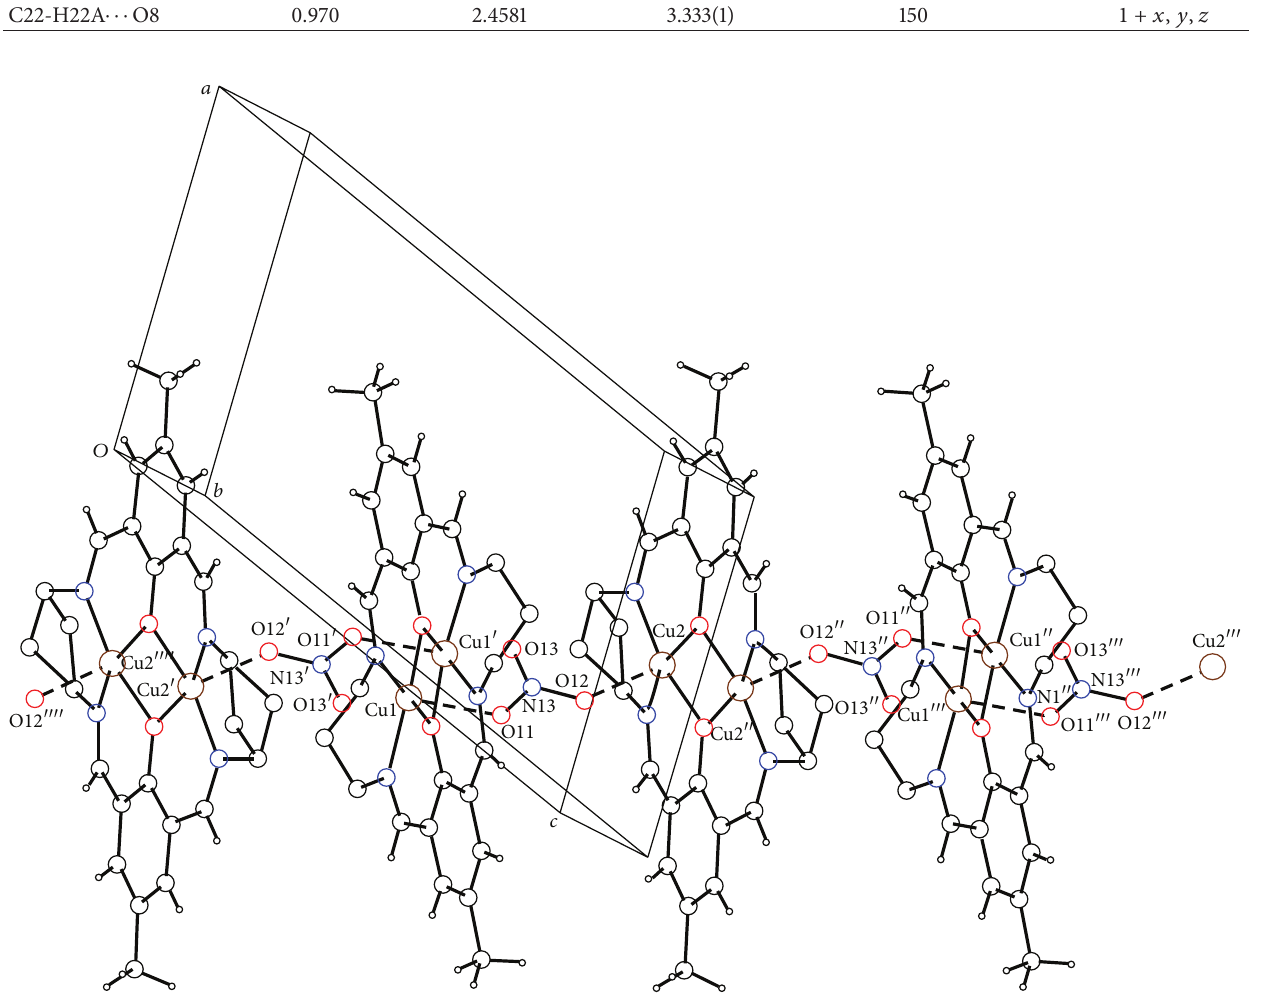
Figure 2: A partial view of the crystal packing of [ { Cu 2 (tidf)( 𝜇 -NO 3 ) } ∞ ]ClO 4 showing the Cu ⋅⋅⋅ O-N(=O)-O ⋅⋅⋅ Cu interactions (dashed lines) resulting in a one-dimensional polymeric arrangement along the [101] crystallographic direction [symmetry codes ( 󸀠 ): −𝑥 , 2−𝑦 , 1−𝑧 ; ( 󸀠󸀠 ): 1 − 𝑥 , 2 − 𝑦 , 2 − 𝑧 ; ( 󸀠󸀠󸀠 ): 1 + 𝑥 , 𝑦 , 1 + 𝑧 ; ( 󸀠󸀠󸀠󸀠 ): −1 + 𝑥 , 𝑦 , −1 + 𝑧 ]. Perchlorate anion and H atoms of methylene groups omitted for